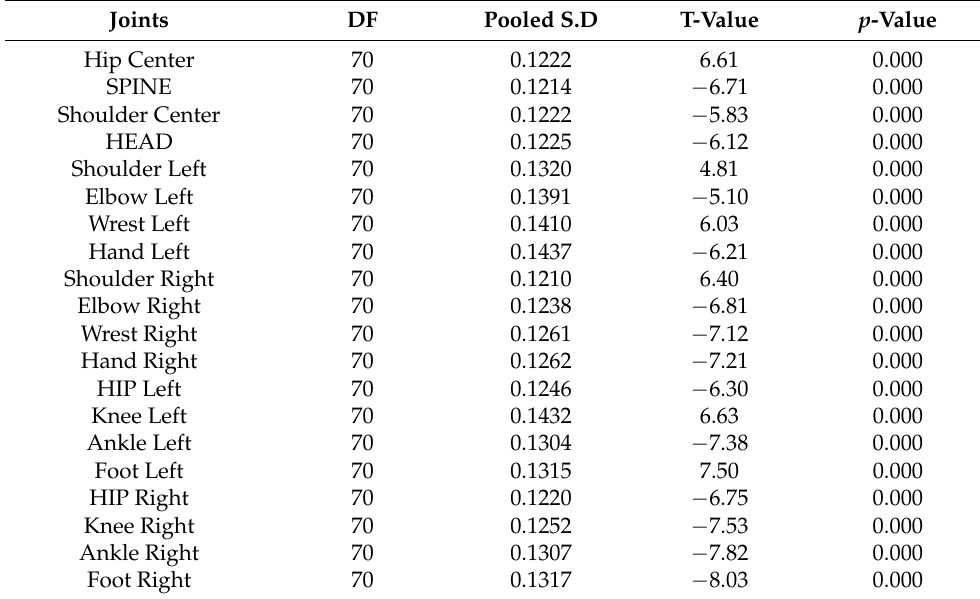
Table 3. The results of the two-sample t -test used for comparison between male and female joints during